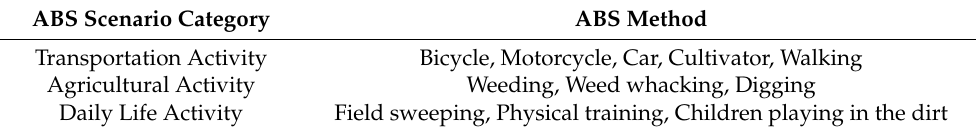
Table 2. ABS method classification in this